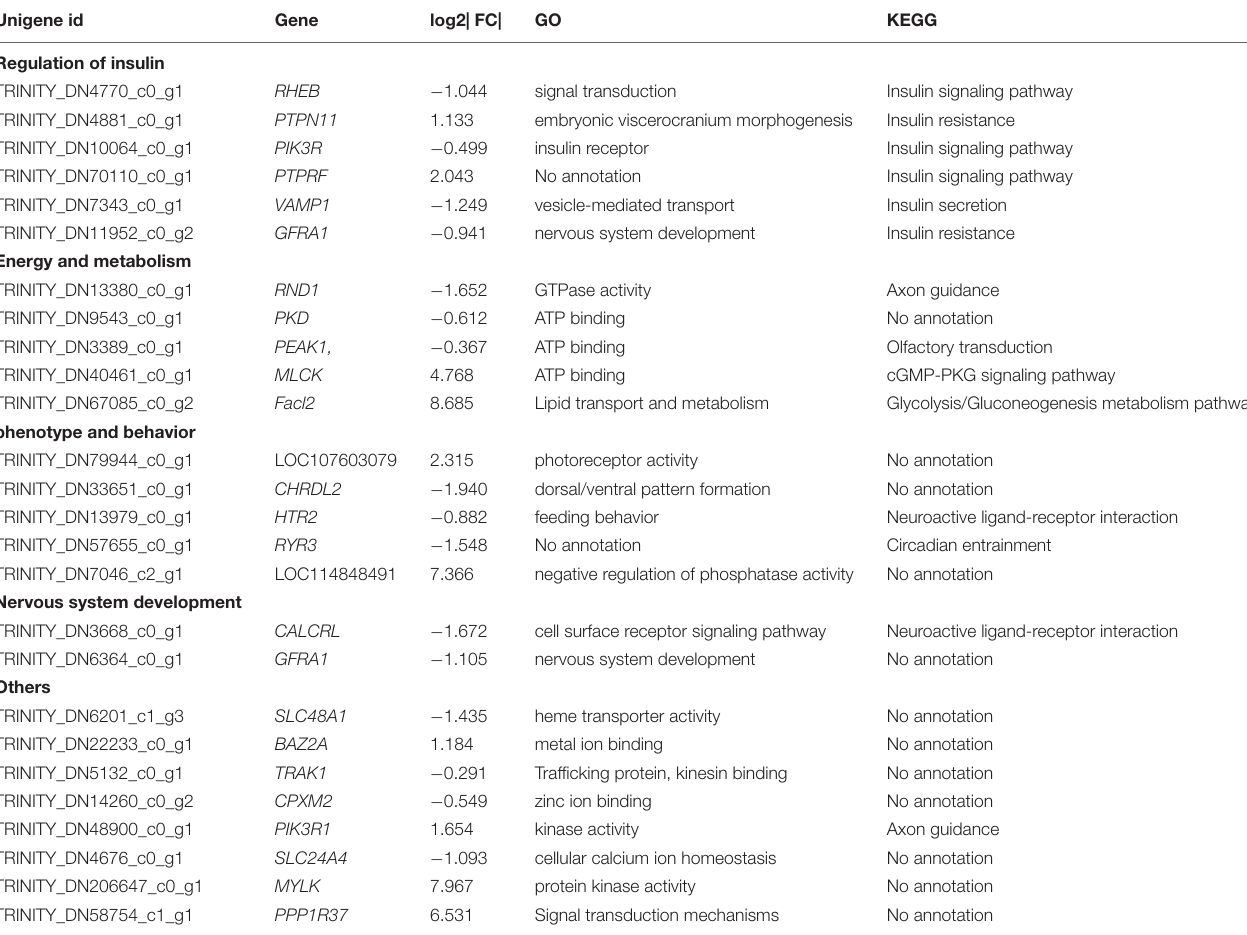
TABLE 7 | The annotation of the hub genes with top 30 connectivity in “blue” and “turquoise” module with differential expression identified by WGCNA. Unigene id Gene log2| FC| GO